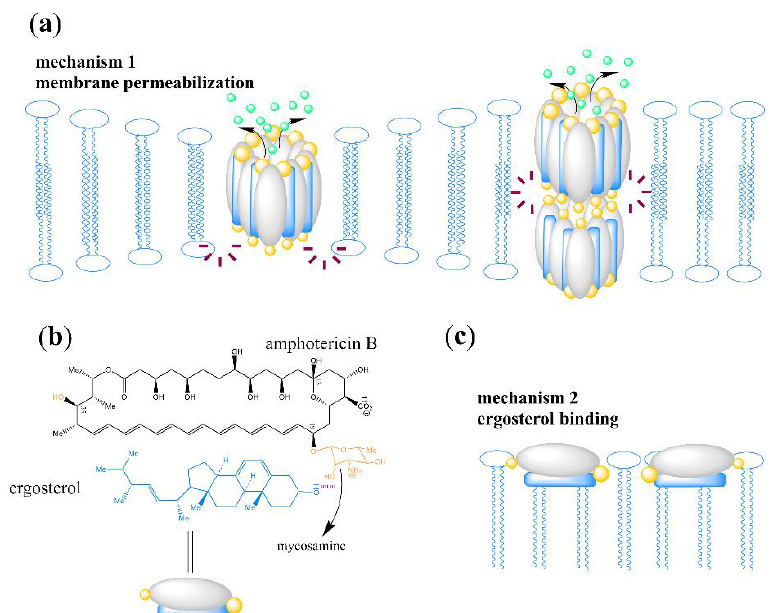
Figure 6. Model and antifungal mechanism of amphotericin B binding to ergosterol. ( a ) The first kind of antifungal mechanism of amphotericin B, membrane permeabilization; ( b ) the model of amphotericin B, ergosterol binding; ( c ) the second of antifungal mechanism of amphotericin B, ergosterol binding [39].